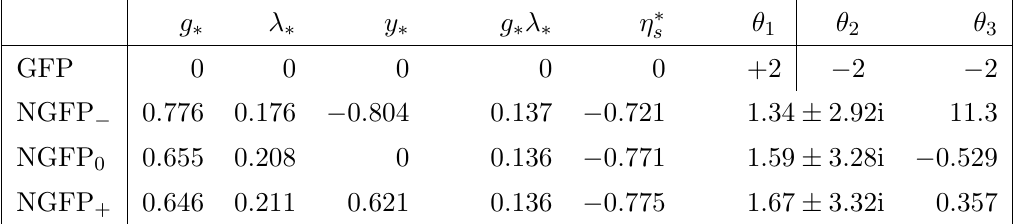
Table 2 . Characteristic features of the four (cid:12)xed points arising from the full set of beta func- tions (3.13) for N s =